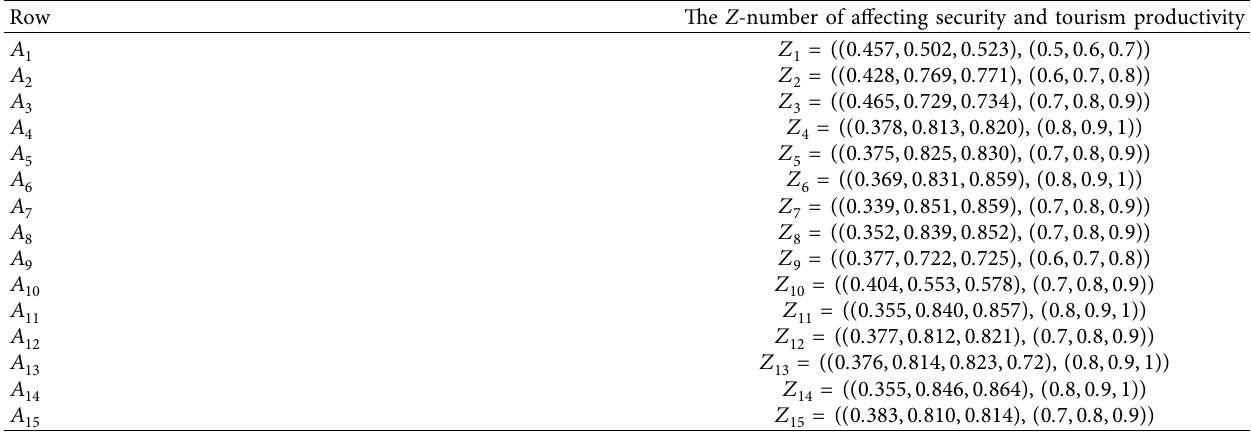
Table 5: Information about 15 factors afecting security and tourism productivity. Row Te Z -number of afecting security and tourism